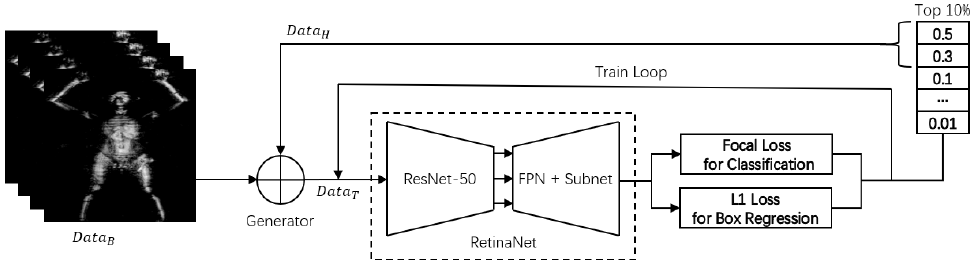
Figure 5. Training process of RetinaNet and Focal Loss combined with